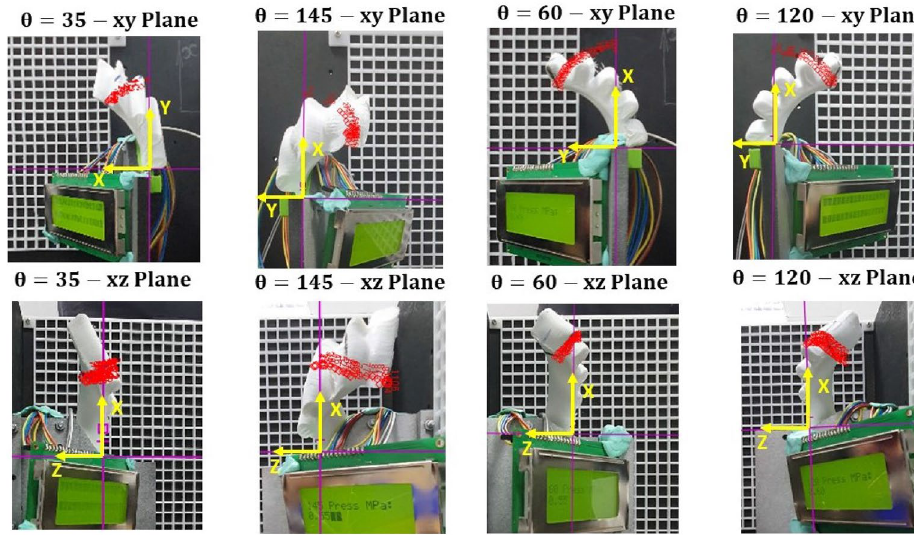
Figure 5. The two frames (XY and XZ) for 4 manufactured SPAs, the figures are snap-shots from tracker software where the origin axis in purple and the tip position throughout the trial is indicated in red